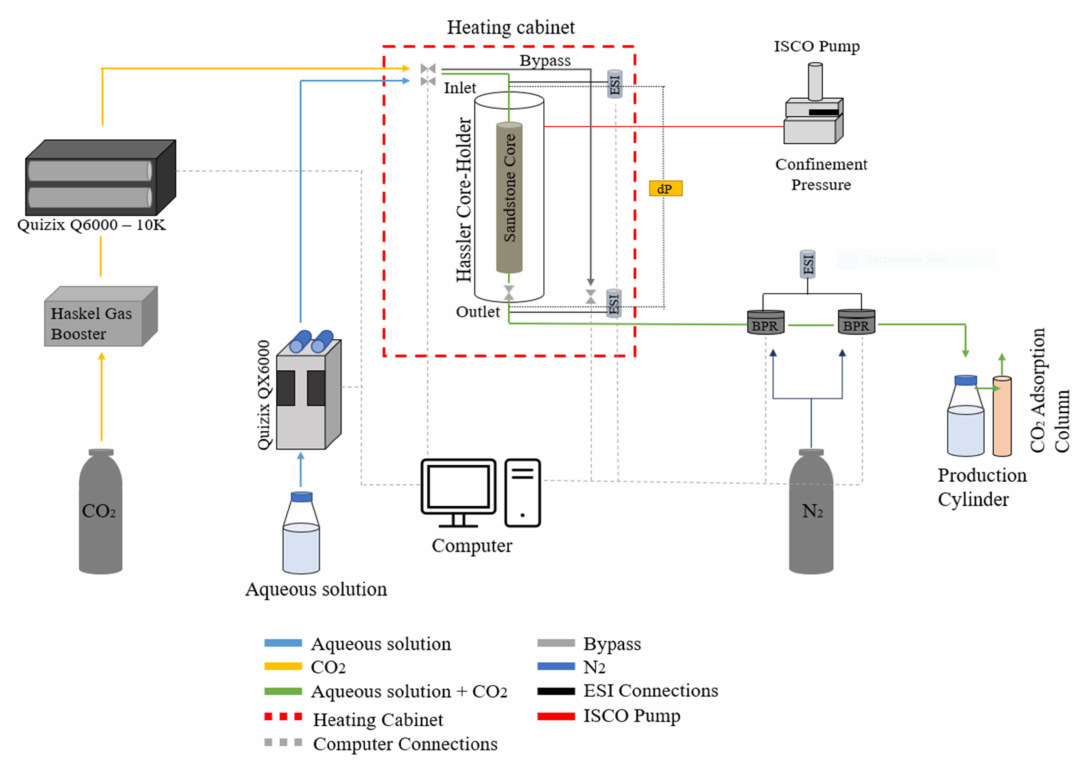
Figure 2. Illustration of experimental setup used for unsteady-state foam